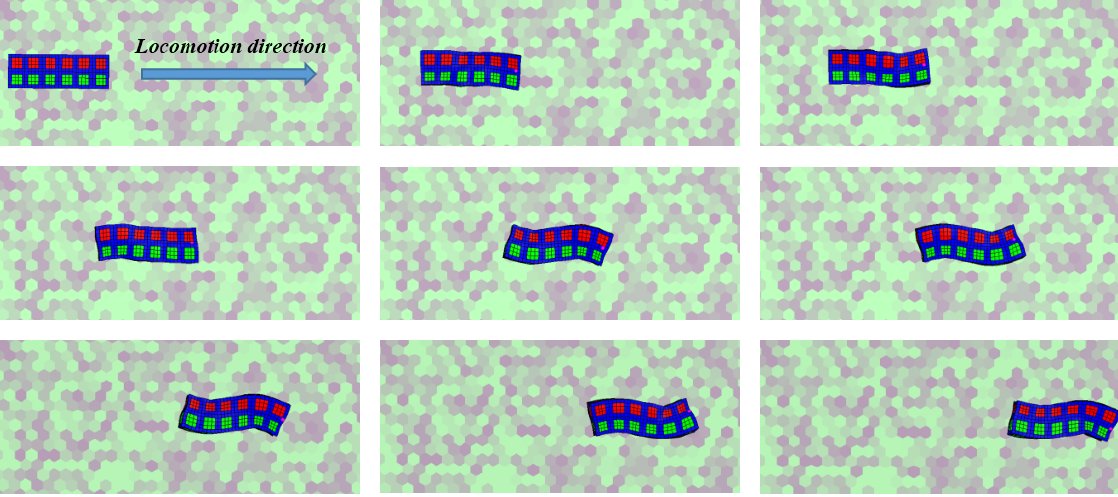
Figure 12. Locomotion Process of snake configuration in the VOXCAD.